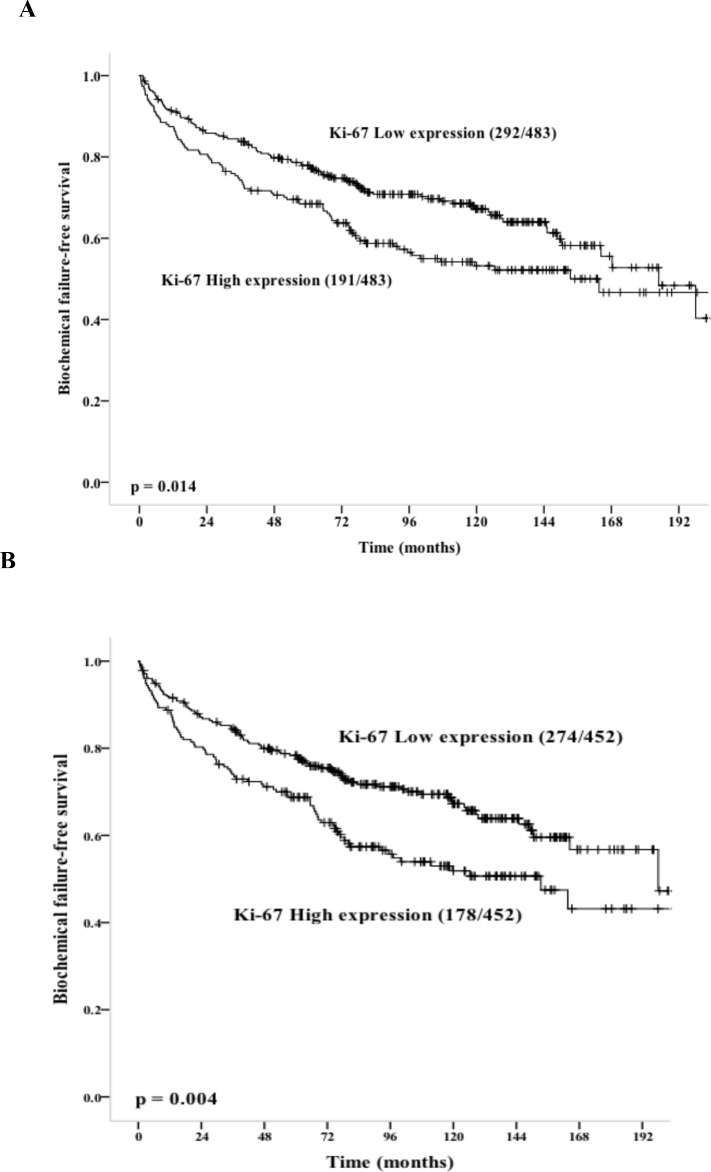
Survival analysis for Ki-67 and mitotic count in primary tumors.(Kaplan-Meier method). Number of events/number of cases are given in parenthesis. (A) Digital scoring; (B) Visual scoring.